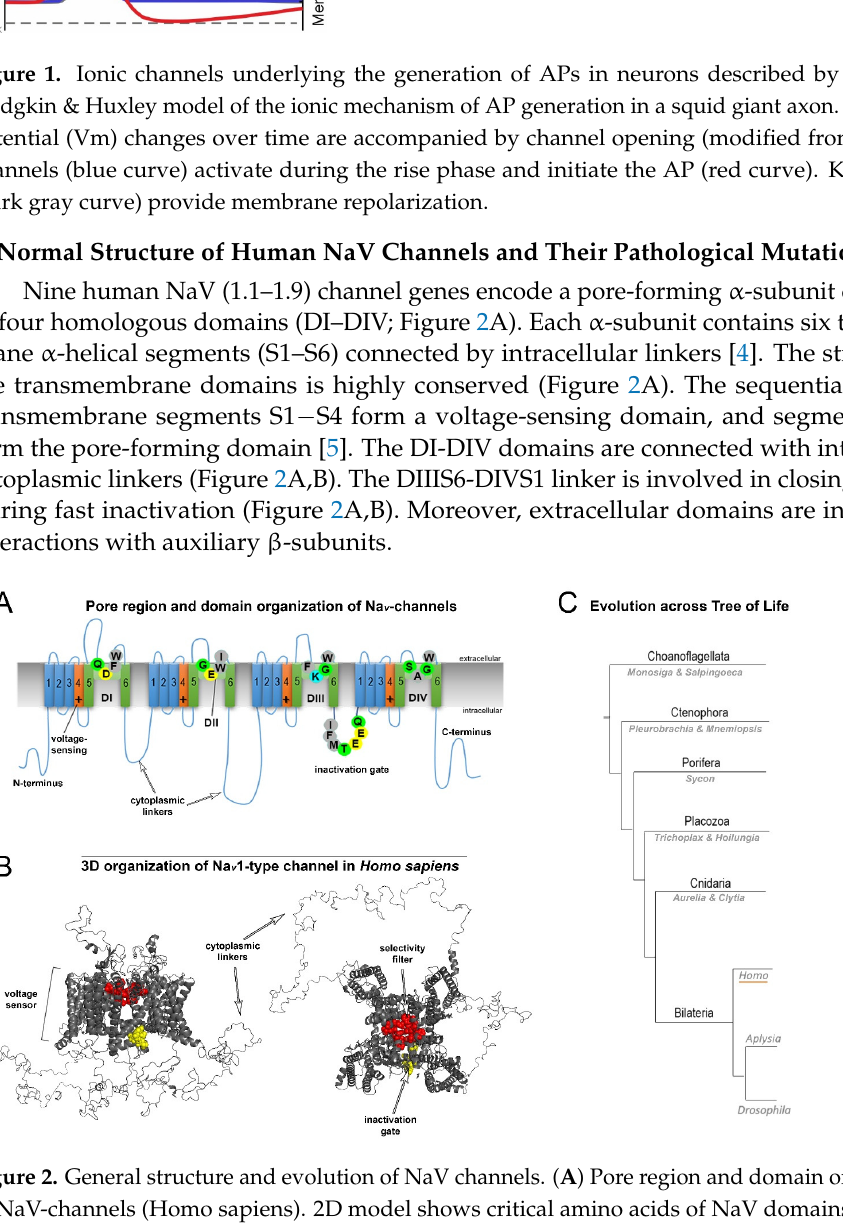
Figure 1. Ionic channels underlying the generation of APs in neurons described by the classic Hodgkin & Huxley model of the ionic mechanism of AP generation in a squid giant axon. Membrane potential (Vm) changes over time are accompanied by channel opening (modified from [1]). Na + channels (blue curve) activate during the rise phase and initiate the AP (red curve). K + channels (dark gray curve) provide membrane repolarization.